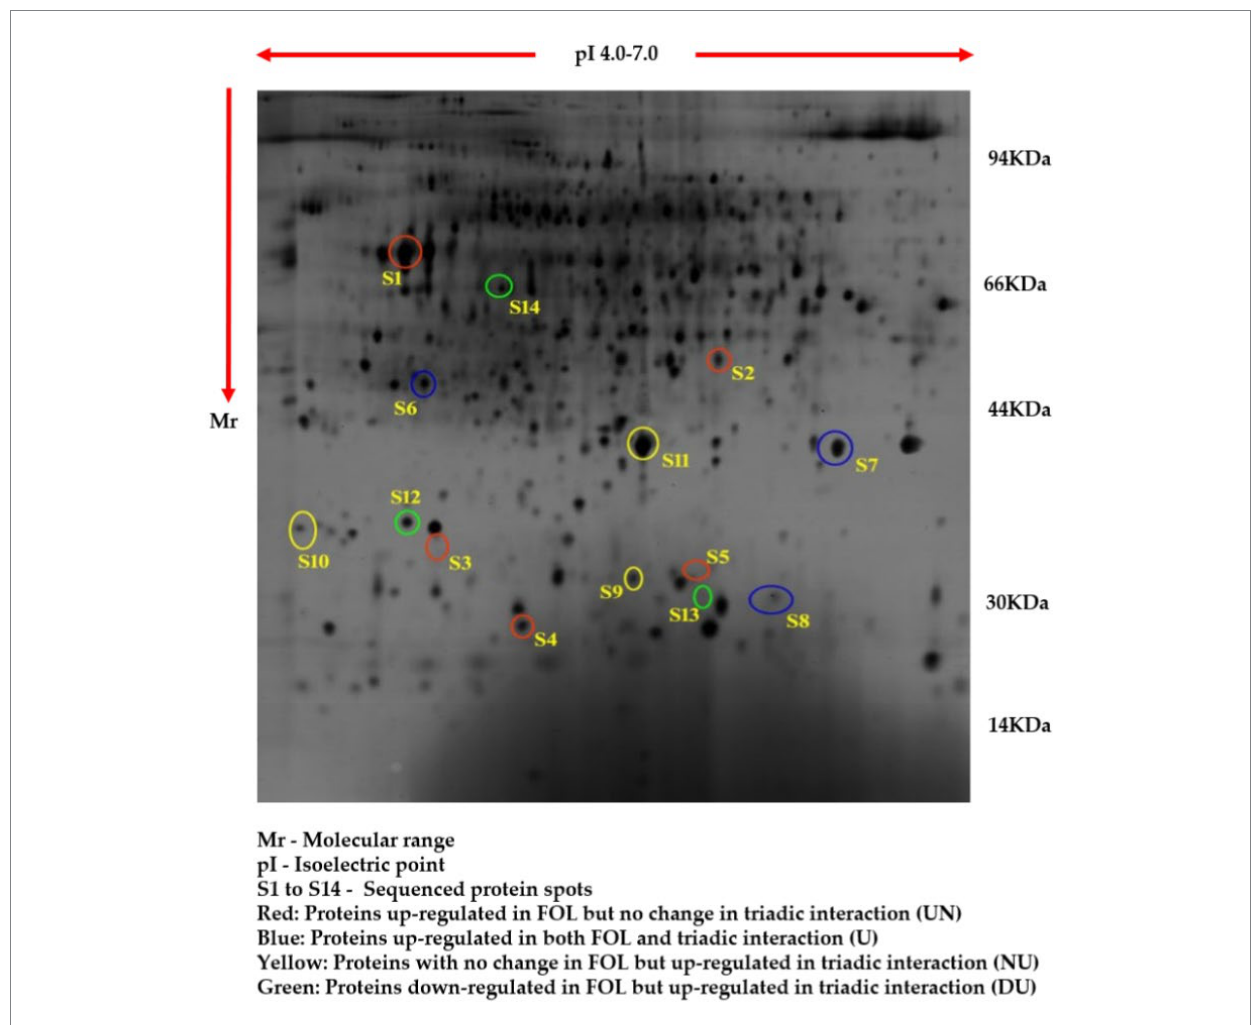
FIGURE 8 Proteome analysis of tomato roots supplemented with TPf1 by